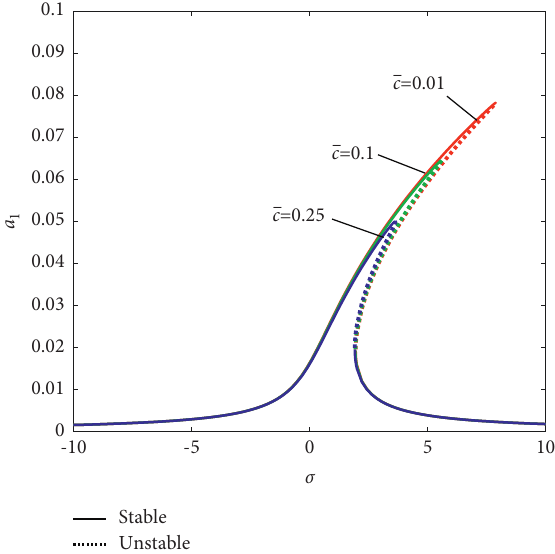
Figure 6: The effect of structural damping on frequency response curve (L/d � 10, θ � 0 ° , case